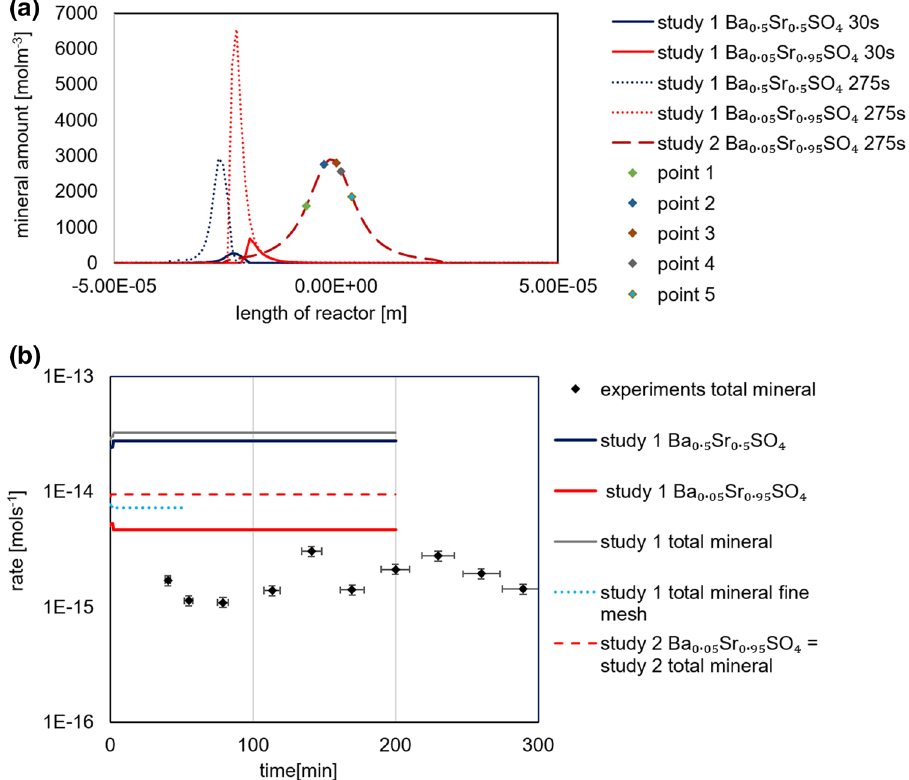
Figure 7. ( a ) Mineral distribution profiles of the two stoichiometric compositions (Ba 0.05 Sr 0.95 )SO 4 and (Ba 0.5 Sr 0.5 )SO 4 across a simulated 1D reactor for case study 1 at 30 and 275 s and case study 2 at 275 s using a discretization of 1 µm. Points 1–5 refer to the sampling points used to calculate nucleation and crystallization kinetics in Fig. 9. ( b ) Comparison of simulated precipitation rates using OGS-GEM with instantaneous precipitation (case study 1) and with kinetic constraints (case study 2) using mesh discretizations of 5 µm and 1 µm against experimental results (total amount of minerals that precipitated per unit